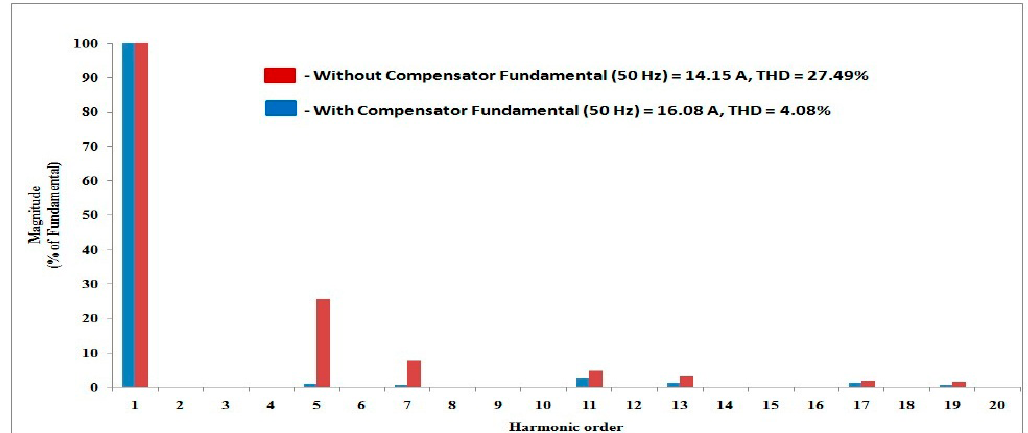
Figure 8. Harmonic spectrum of supply current before and after compensation.